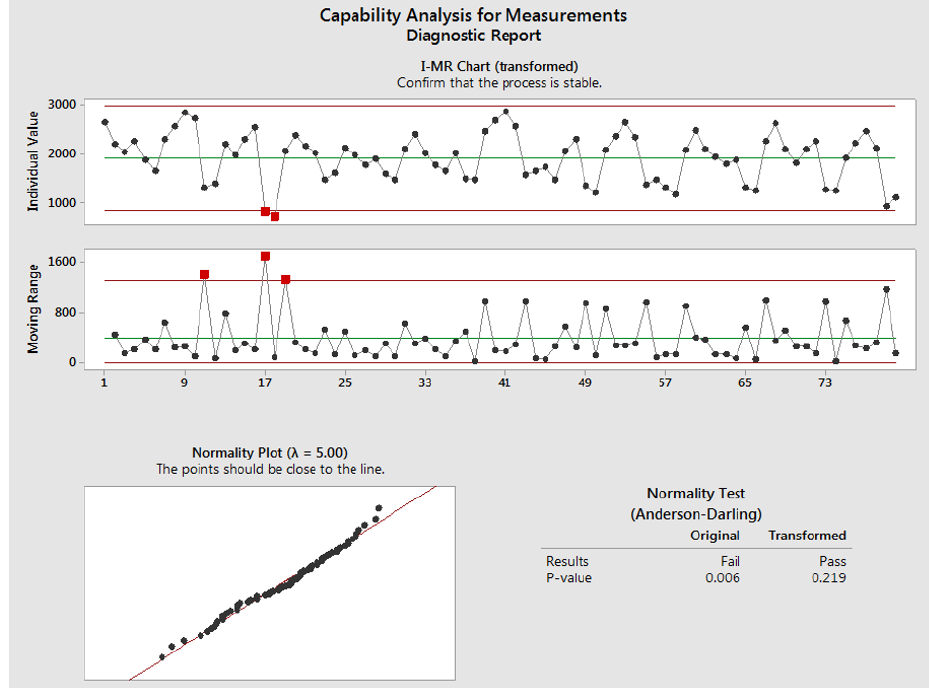
Figure 18. Capability analysis for measurements.